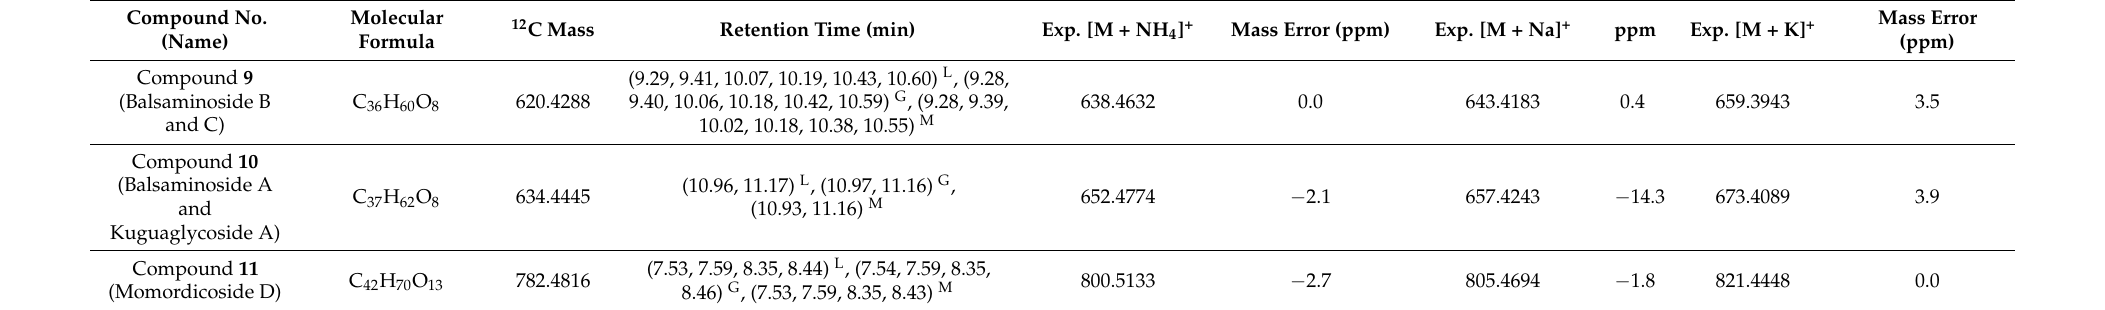
Table 3. Cucurbitane-type Triterpenoids Glycosides Identified in M. balsamina using